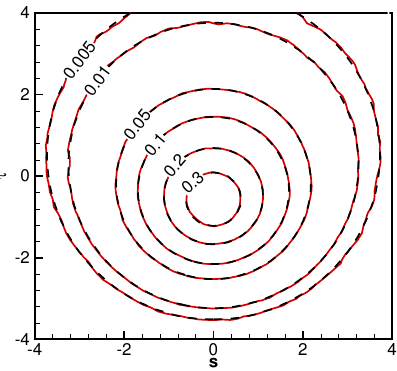
Figure 18. Specular plate, pressure contours, C p , s ( s , τ ) , S 0 = 2.0, α 0 = 60 ◦ , T w / T 0 = 1.5. Plate lengths are normalized by the nozzle diameter. Solid: analytical; dashed: DSMC.